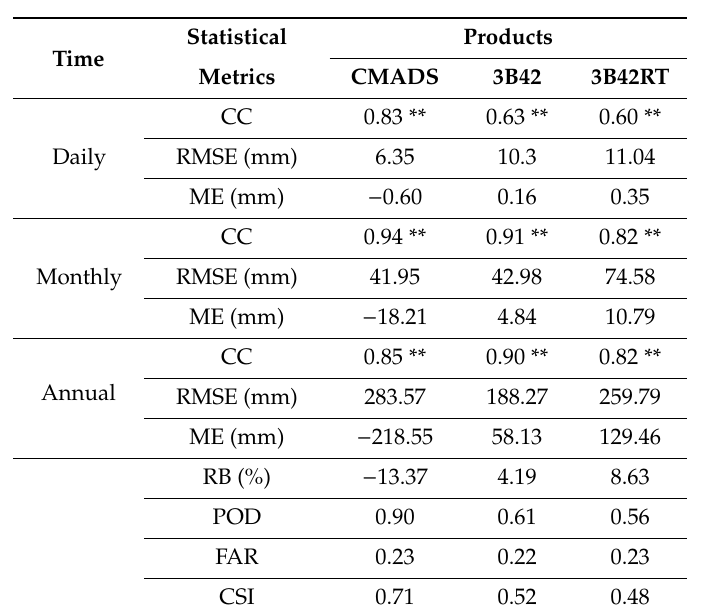
Table 2. Summary of statistical metrics for CMADS and TMPA daily, monthly and annual precipitation in the GRB. The metrics were calculated based on the grids with rain